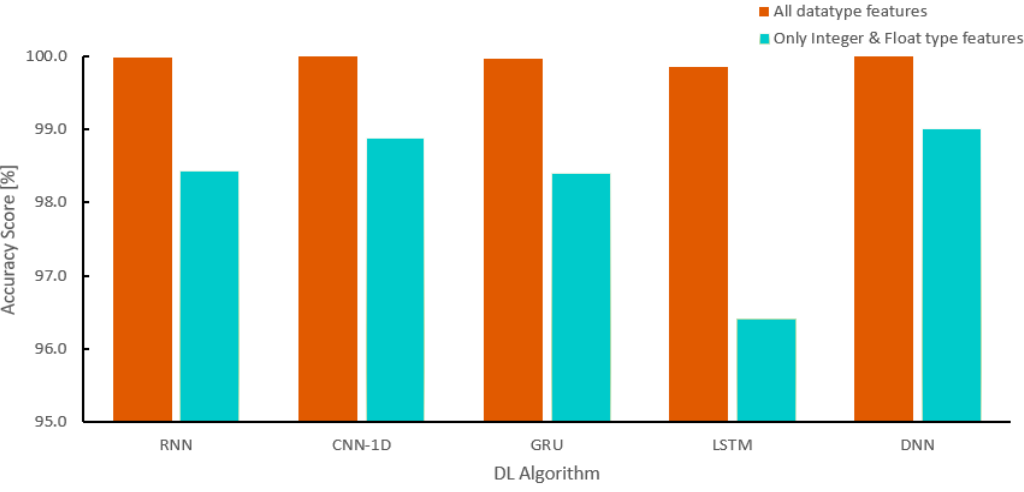
Figure 11. Comparison of Accuracy scores considering different features of different data types.